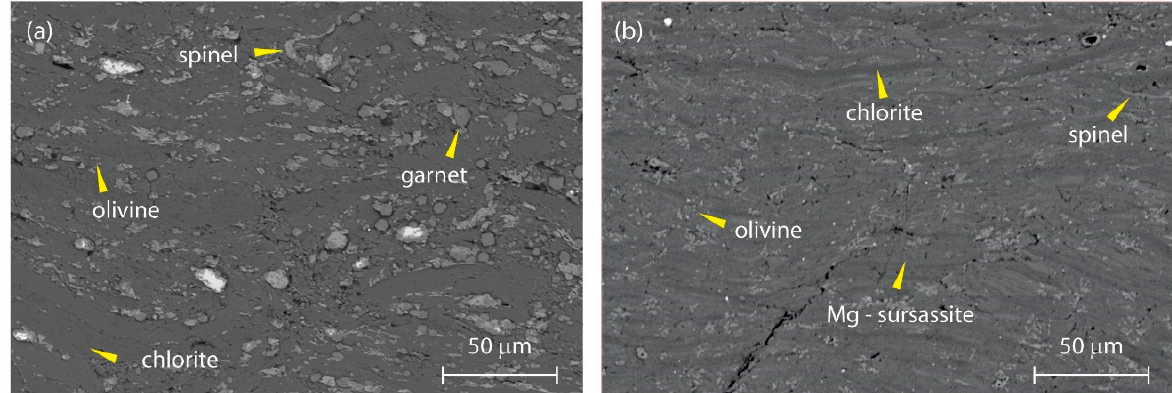
Figure 3. Scanning electron microscope backscattered electron images showing the chlorite sample after dehydration at ( a ) 1.8 GPa and ( b ) 3.8 GPa.